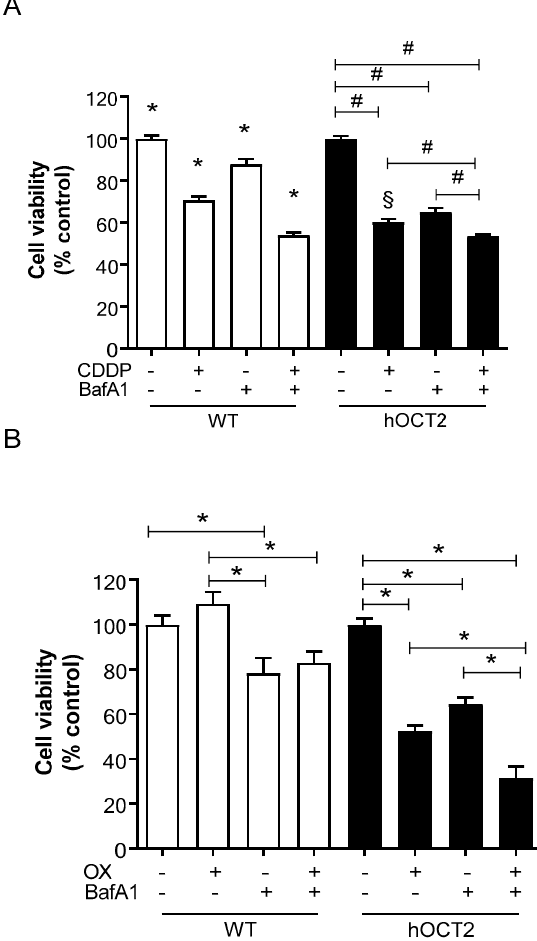
Figure 6. This figure shows the cytotoxic effects measured with an MTT assay in HEK293-WT (WT, open bars) and -hOCT2 (hOCT2, closed bars) cells after 6 h incubation with 100 µ M CDDP (panel A ) or 100 µ M OX (panel B ) in the presence or absence of 100 nM bafilomycin A1, followed by a 48 h postincubation with drug-free medium. Each bar shows the mean ± SEM of 6 replicates measured in three independent experiments. Panel ( A ): * represent a statistically significant difference between the indicated groups ( p < 0.05, ANOVA with Tukey post hoc test) and all the others. # shows a statistically significant difference in the indicated groups ( p < 0.05, ANOVA with Tukey post hoc test). § shows a statistically significant difference between the effect of treatment in WT and hOCT2 cells ( p < 0.05, unpaired t -test). Panel ( B ): * show a statistically significant difference between the effect in the indicated groups ( p < 0.05, ANOVA with Tukey post hoc